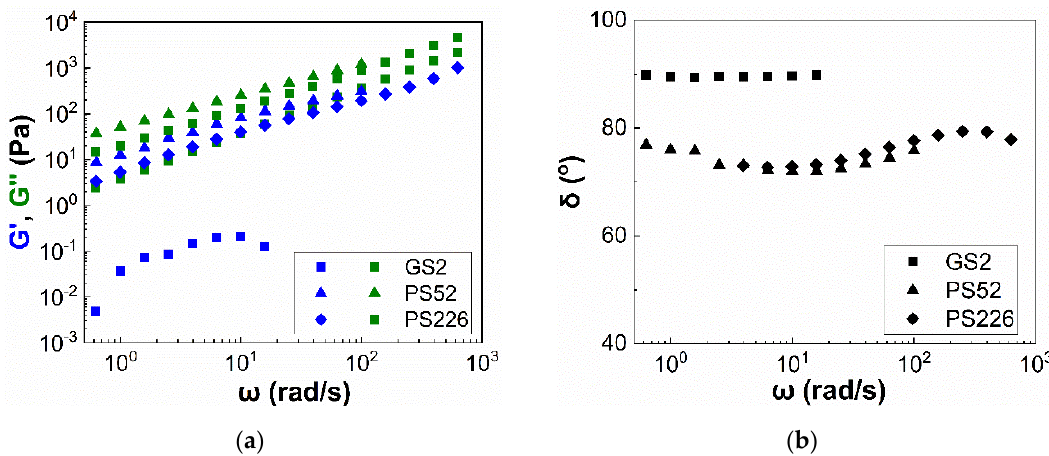
Figure 7. ( a ) Viscoelastic moduli ( G (cid:48) , G (cid:48)(cid:48) ) and ( b ) phase angles ( δ ) of the three types of particle suspensions in glycerol as a function of the angular frequency ( ω ) at a fixed particle volume fraction of ϕ = 0.30. The suspension at ϕ = 0.20 is used for the PS226 particles, as this is the highest particle volume fraction achieved to provide a homogeneous sample by visual inspection.